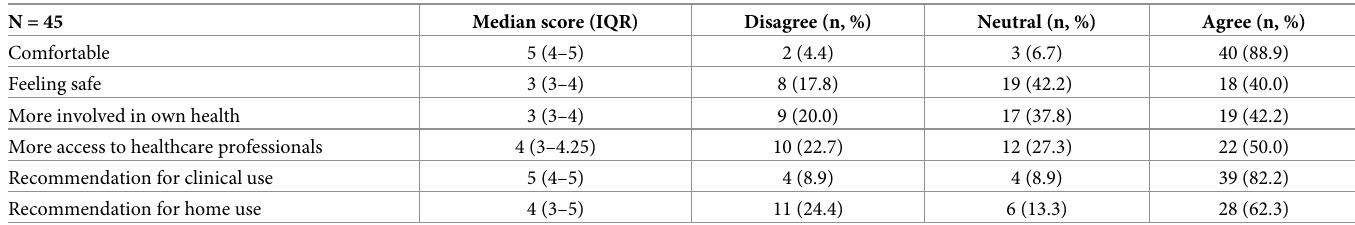
Table 5. Patient